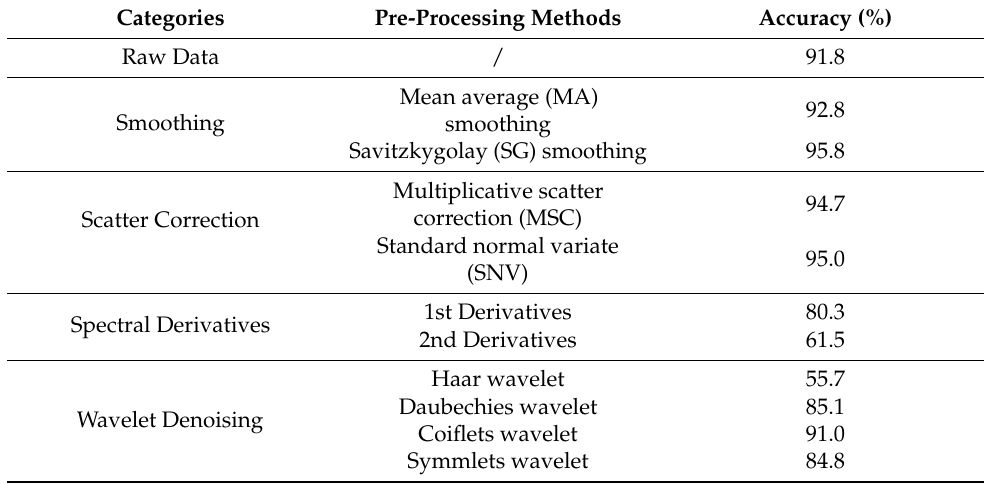
Table 3. The accuracy results of the 1D-CNN model with different preprocessing methods.